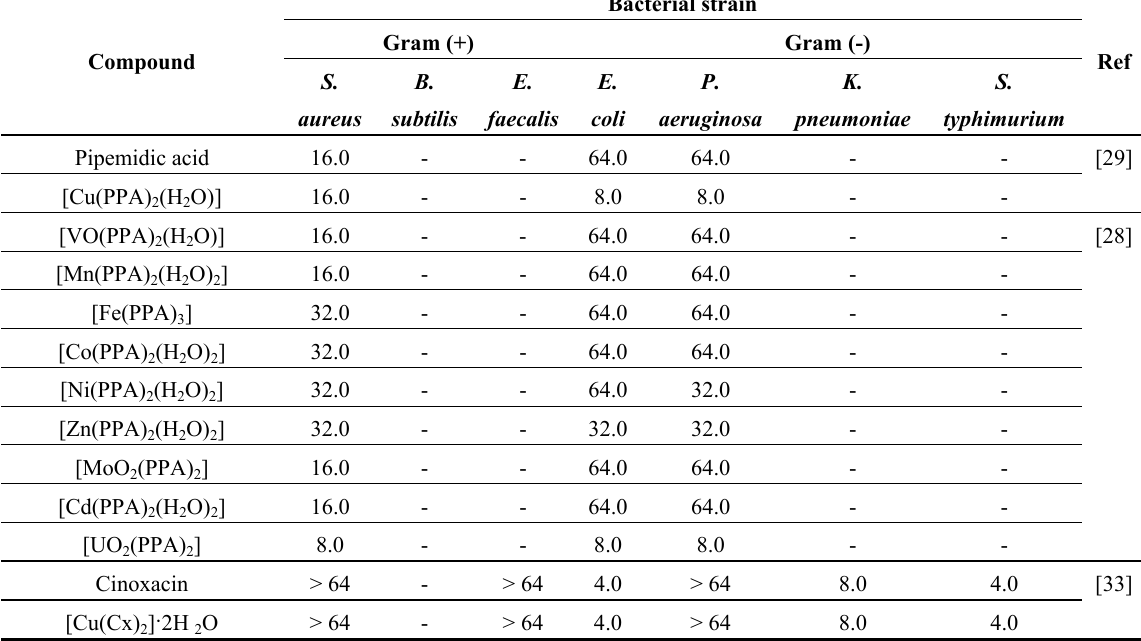
Table 7. Minimal inhibitory concentration (MIC, μ g mL − 1 ) of the drugs for some assayed